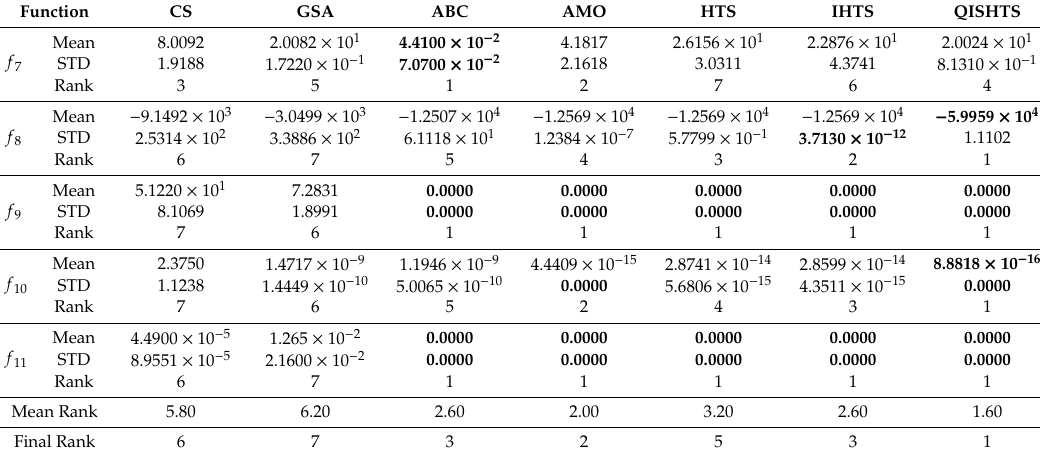
Table 3. Computational results of f 7 to f 11 for the QISHTS algorithm with other MHAs in Investigation 1. (The results of the competitors are adapted from the literature [44]).